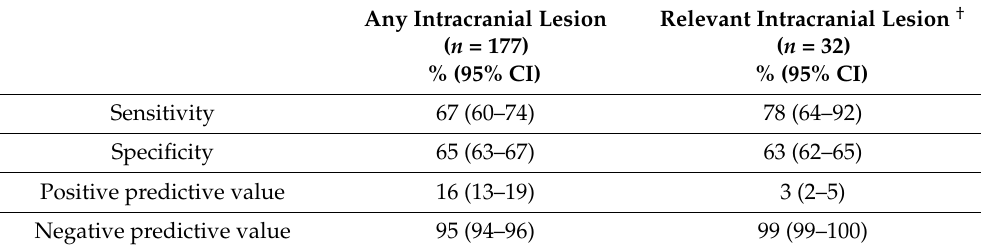
Table 5. Subgroup analysis of the predictive value of clinical TBI characteristics * in elderly patients with a maximal GCS score ** ( n =